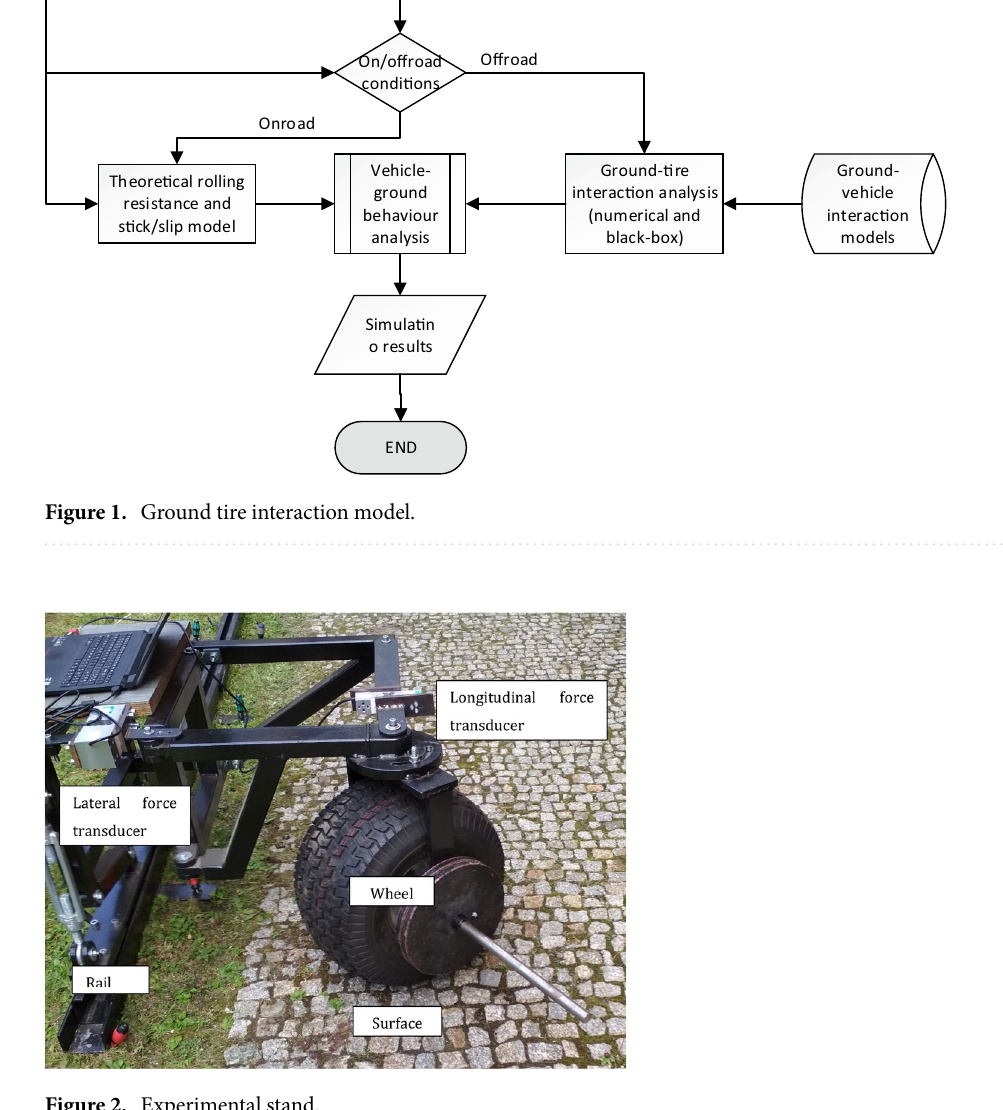
Figure 2. Experimental